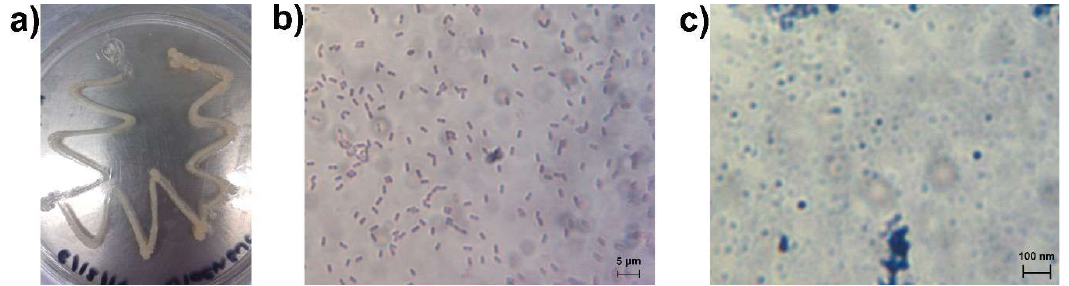
Figure 3. Macro and microscopic traits of the B. halotolerans MCC1 strain. ( a ) Bacterial colonies on nutritive agar; ( b ) bacterial Gram stain; ( c ) bacterial sporulation.